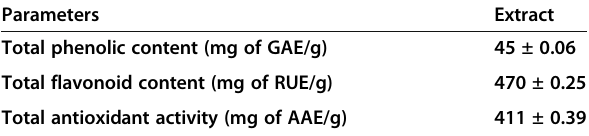
Table 3 Total phenolic, flavonoid, and antioxidant activity of C. vulgaris Parameters Extract Total phenolic content (mg of GAE/g) 45 ± 0.06 Total flavonoid content (mg of RUE/g) 470 ± 0.25 Total antioxidant activity (mg of AAE/g) 411 ±